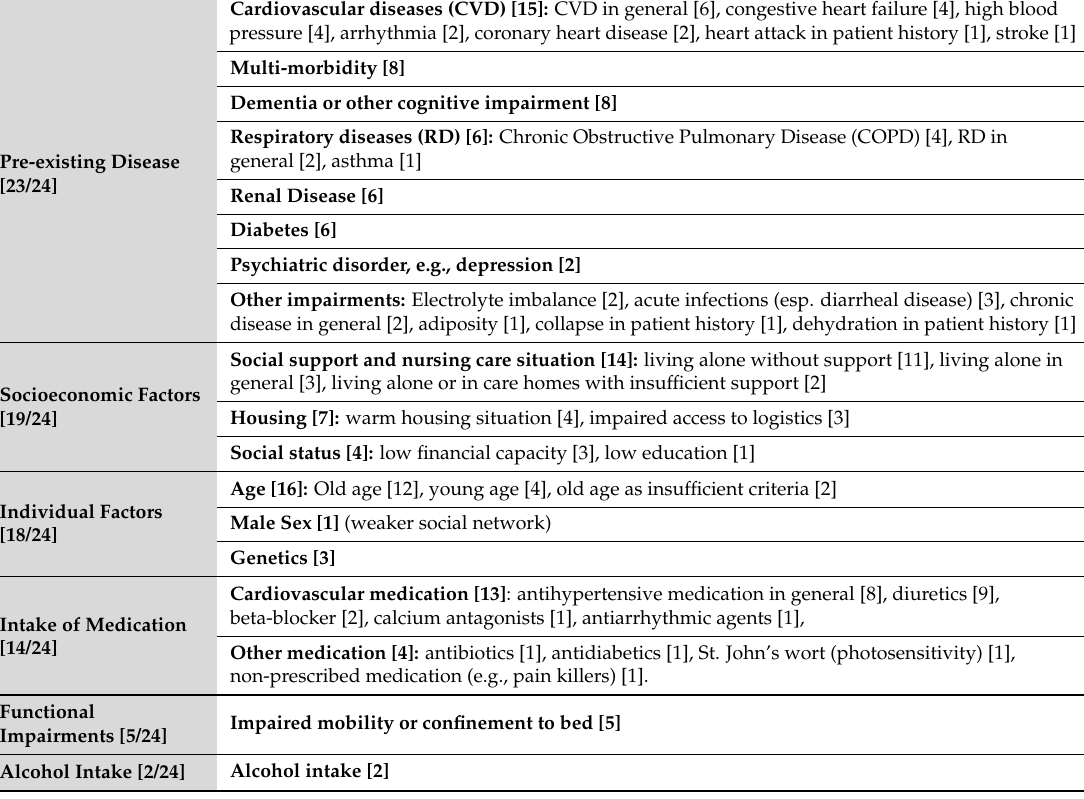
Pre-existing Disease